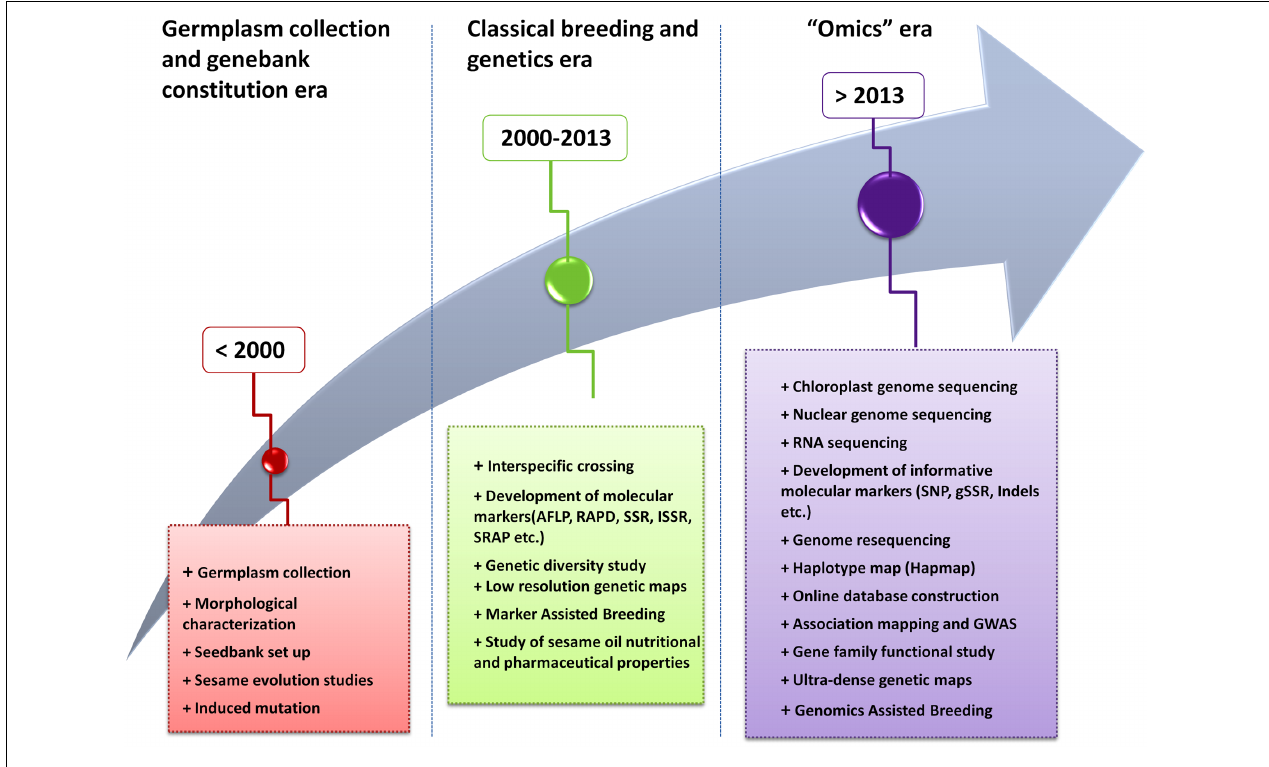
FIGURE 2 | Evolutionary history of the scientific research on sesame.